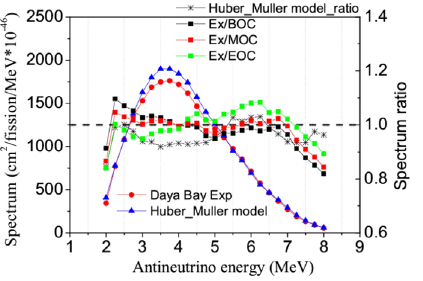
Figure 7. Comparison spectra of method-3 with Daya Bay mea- sured